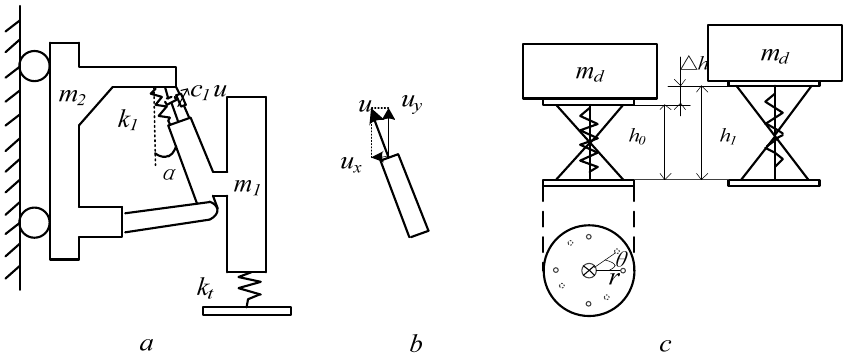
Figure 5. The structure diagram of the multi-link active suspension. ( a ) Real model of suspension.